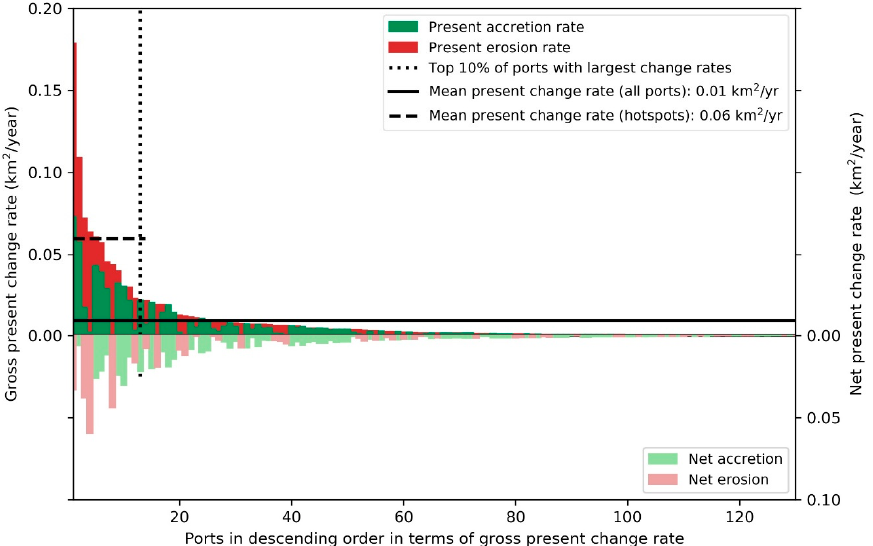
Figure 10. Present gross (left y -axis) and net (right y -axis) areal change rates (in km 2 / year) for all 130 seaports in descending order based on the gross change rates. The bars show the gross (above x -axis) and net (below x -axis) accretion (green) and erosion (red) rates. The present mean coastal change rates for all ports and the top 10% are indicated by the solid and dashed black lines, respectively.